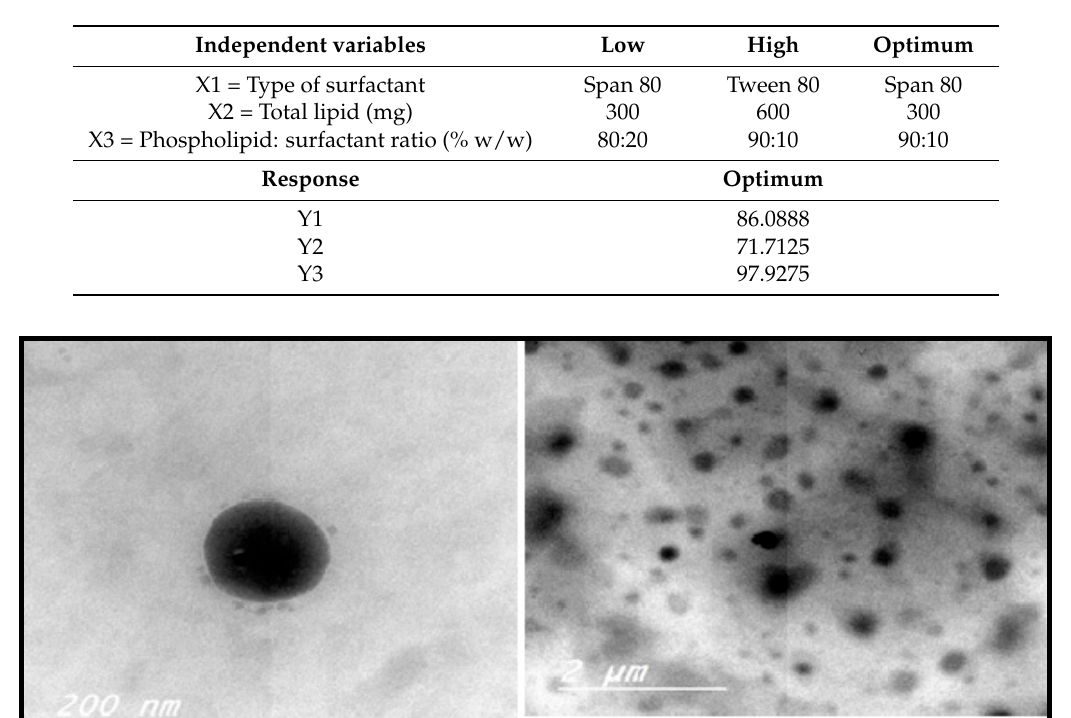
Table 6. Composition of factors and response for the optimized MIC Transfersomes.